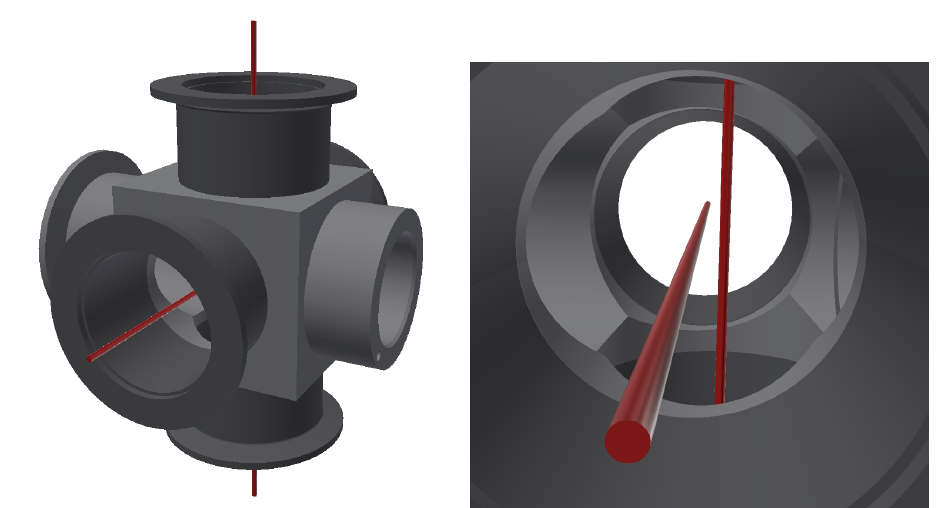
Figure 2. Computer-Aided Design (CAD) drawing of the Magic-Box that allows to operate two one-dimensional UniBEaM detectors (horizontal and vertical) and features five KF-50 flanges and a specific connection for the solid target station ( left ). Particular of the sensing fibers (drawn in red) ( right ). The distance between the planes in which the fibers move is 5 mm.